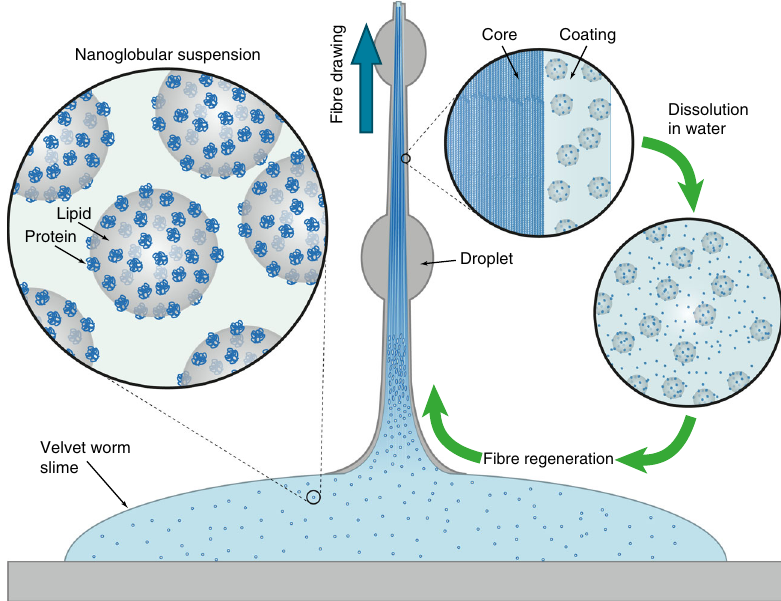
Fig. 4 Proposed model of velvet worm slime fi bre formation and recycling. The slime of E. rowelli consists of monodisperse lipid-protein nanoglobules. Mechanical drawing of fi bres produces a protein-rich fi brous core and lipid-enriched coating. However, fi bres can dissociate into nanoglobules in water, and can be further regenerated from this